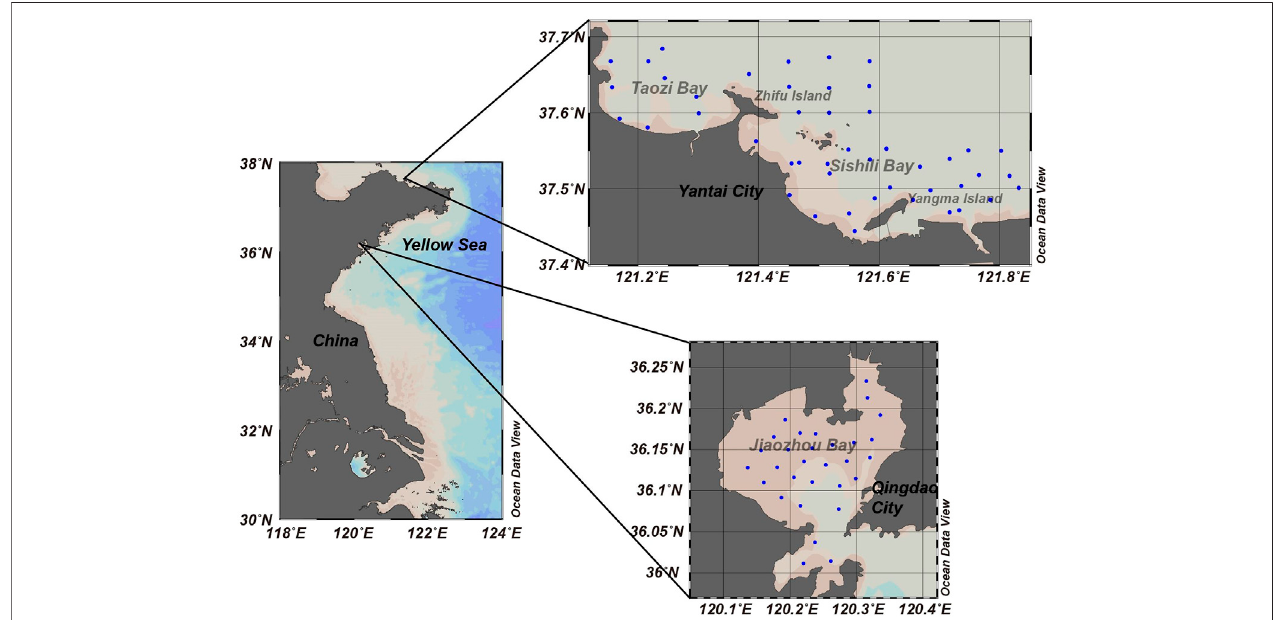
FIGURE 1 | Sampling sites (marked by blue circles) in Jiaozhou Bay, Sishili Bay, and Taozi Bay, China.